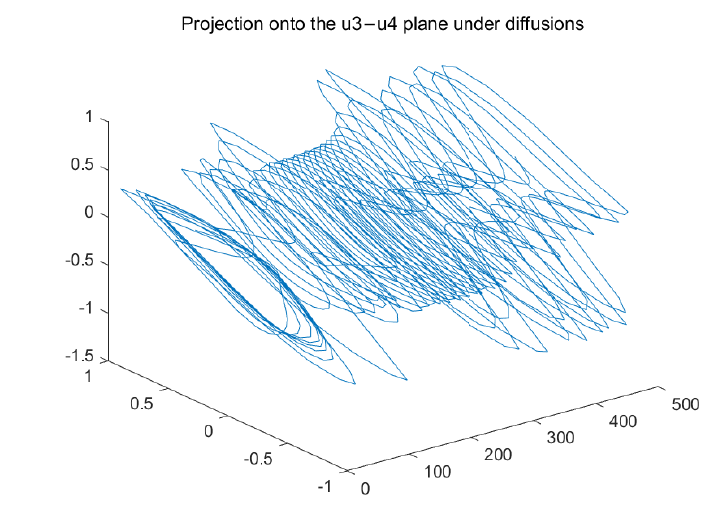
Figure 9. Computer simulations of chaos of financial system under